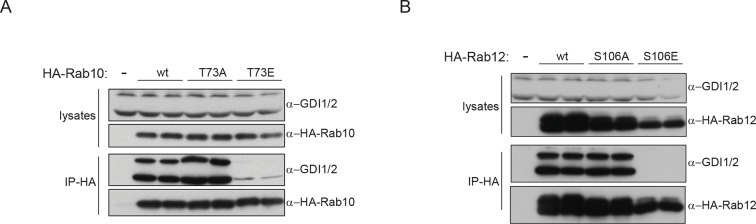
Rab10/12-GDI interactions.(A) HA-Rab10 constructs (wt, T73A, T73E) were expressed in HEK293 cells and lysates subjected to α-HA immunoprecipitation before western blotting. (B) Same as (A) using HA-Rab12 (wt, S106A, S106E). wt, wild type.